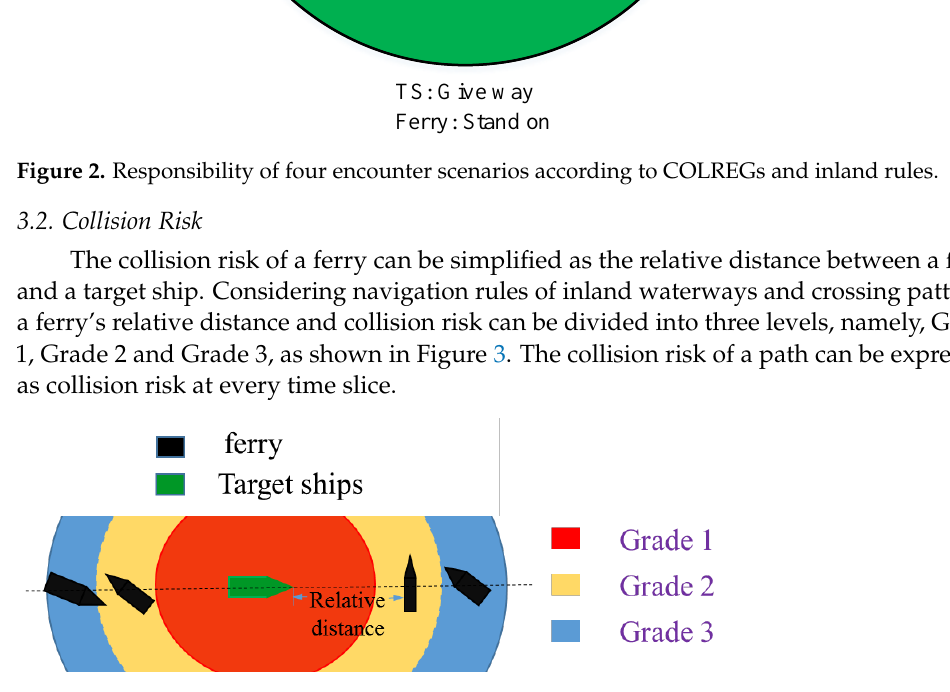
Figure 3. Crossing safety grades classification.